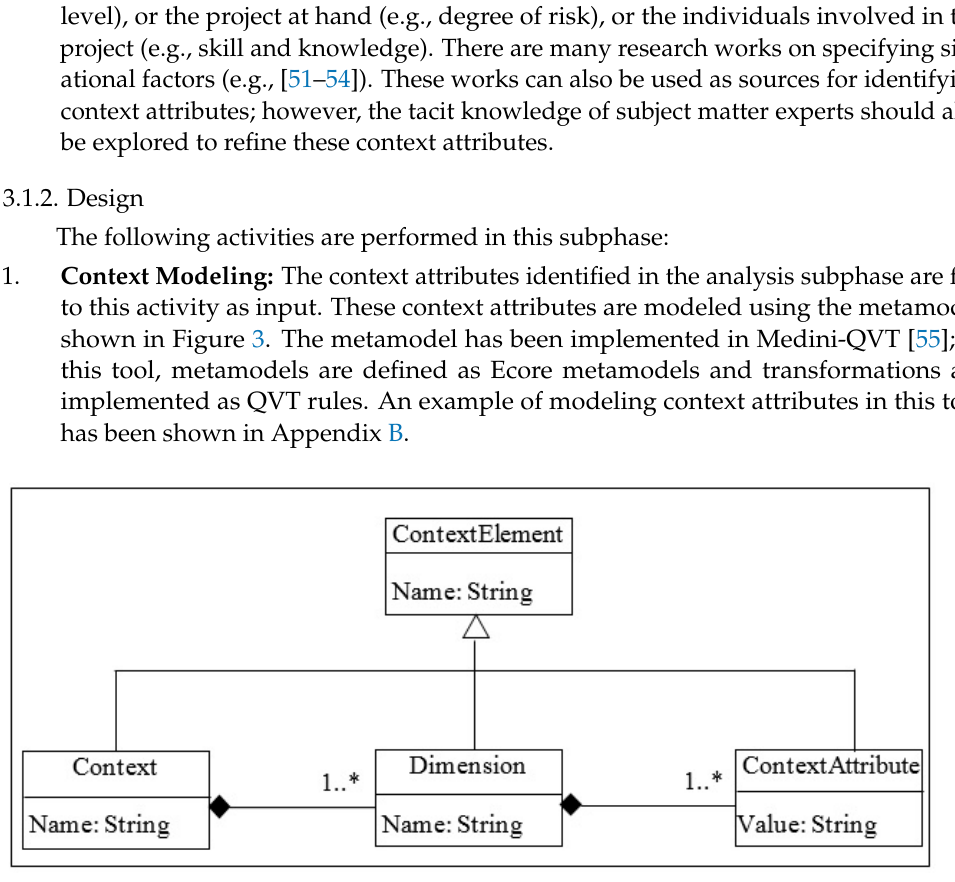
Figure 3. Context